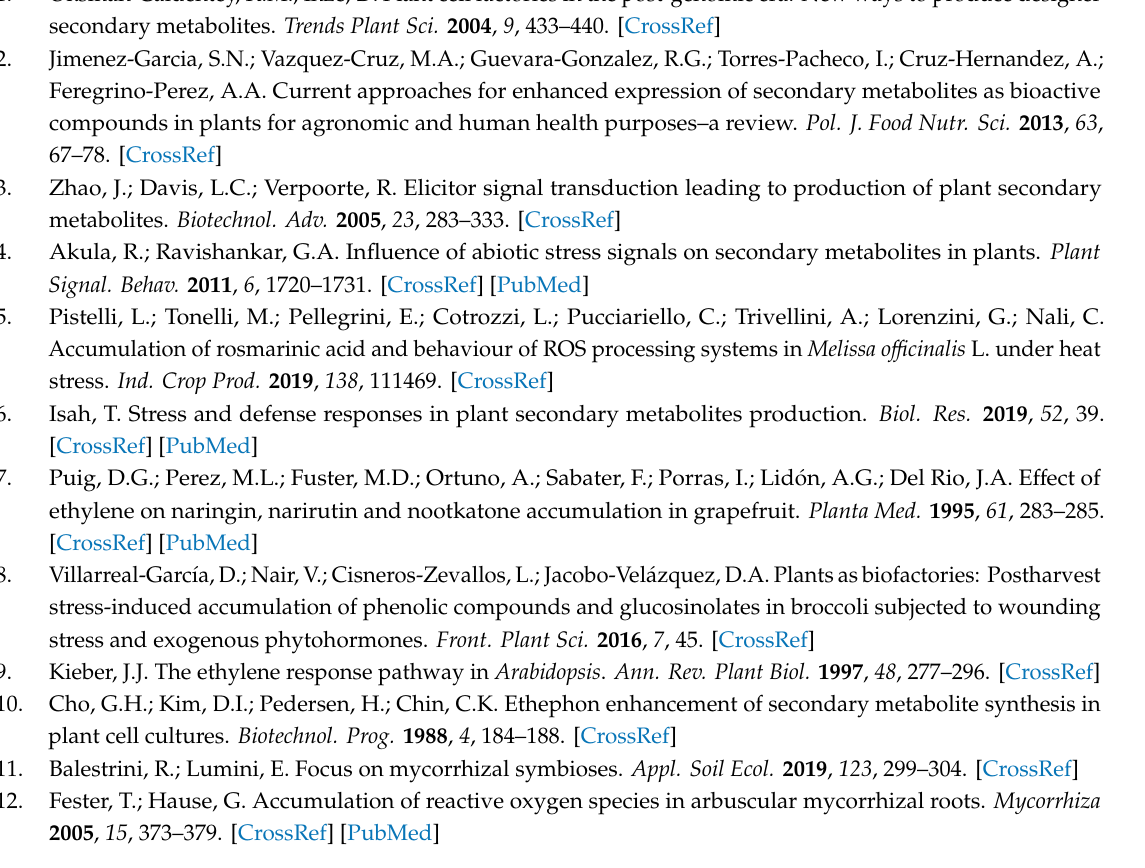
Figure S1: Boxplot showing the number of observed nodules in inoculated plants; Figure S2: Results of AM colonization assessment; Table S1: Results on trigonelline and ABA content with statistical